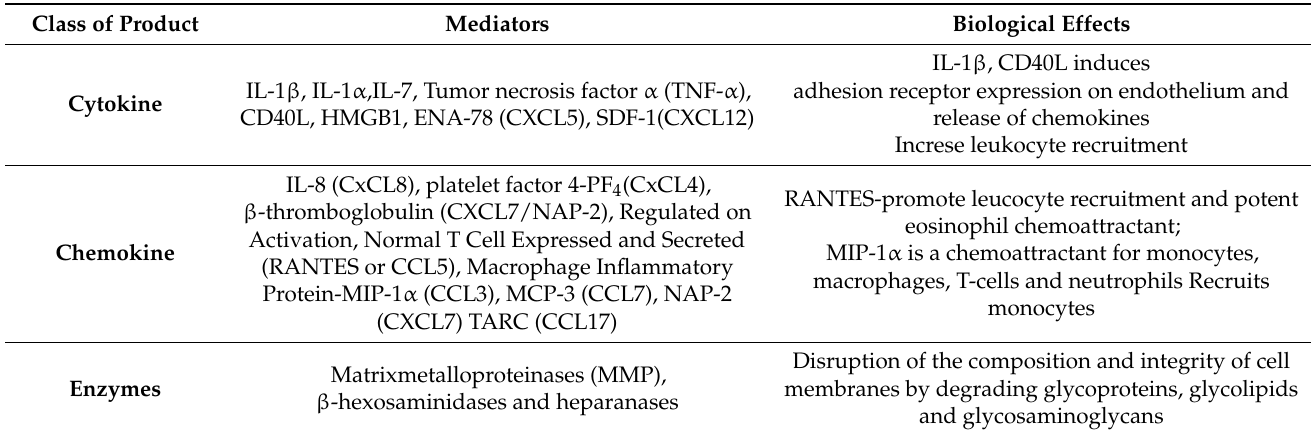
Table 7. Inflammatory mediators synthesized by and stored in